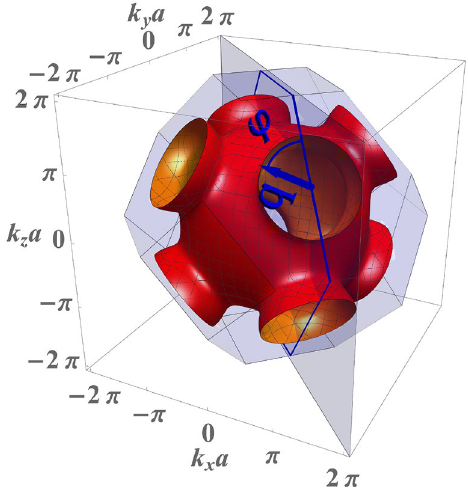
Fig. 2 Open Fermi-surface of one of the conduction bands with eight “necks” at L-points of the fcc crystal’s BZ, shown within the cubic cell of the reciprocal bcc lattice, with BZ shaded in gray. Also shaded in gray one of the planes, traversing four L- and two X-points of the BZ, used to define direction (through angle 𝜑 ) of quasimomentum q lying within the hexagonal edge of BZ around